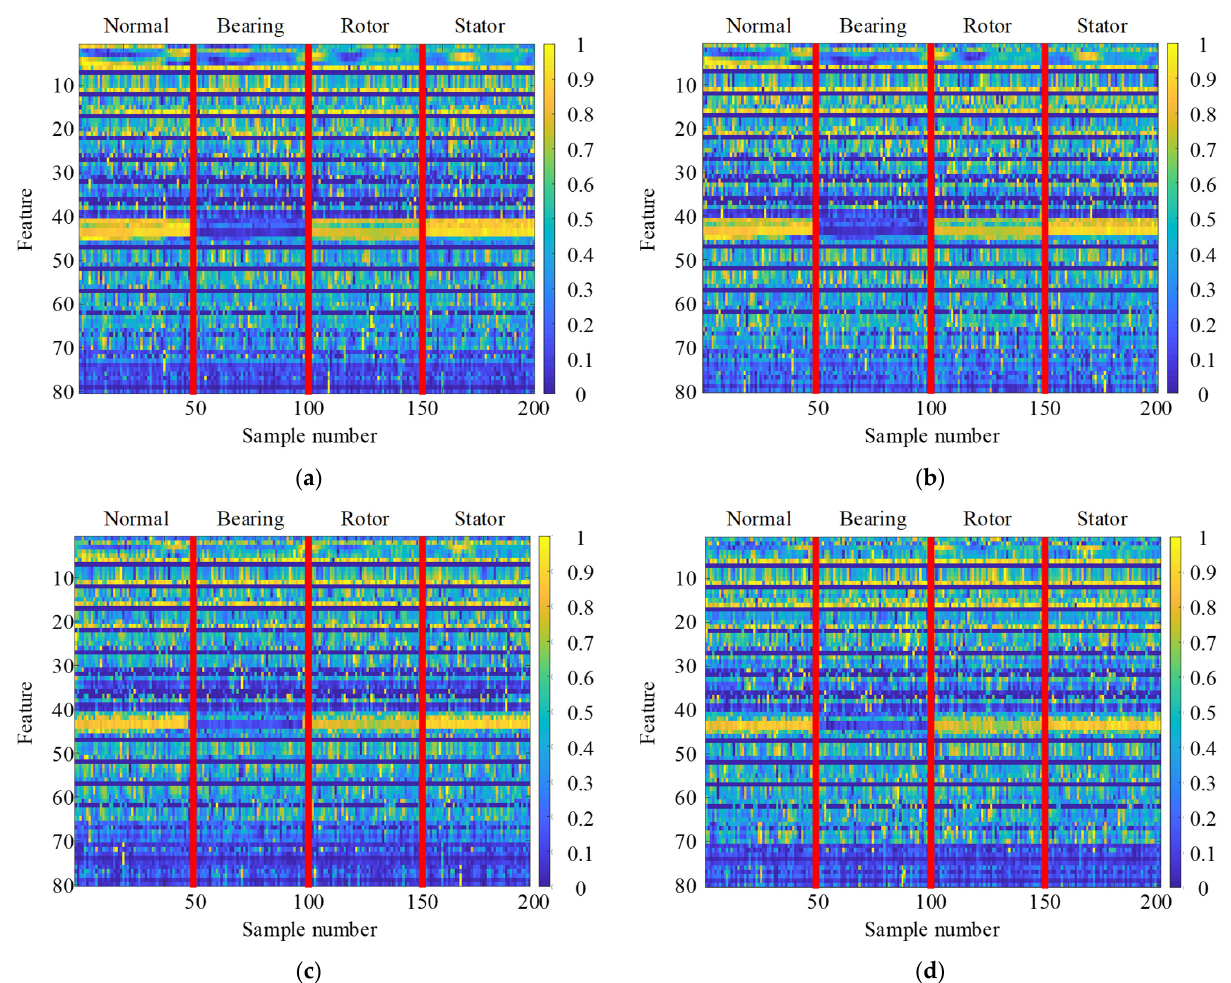
Figure 4. ( a ) Feature map of motor failure (without noise), ( b ) feature map of motor failure (40 dB), ( c ) feature map of motor failure (30 dB), ( d ) feature map of motor failure (20 dB).